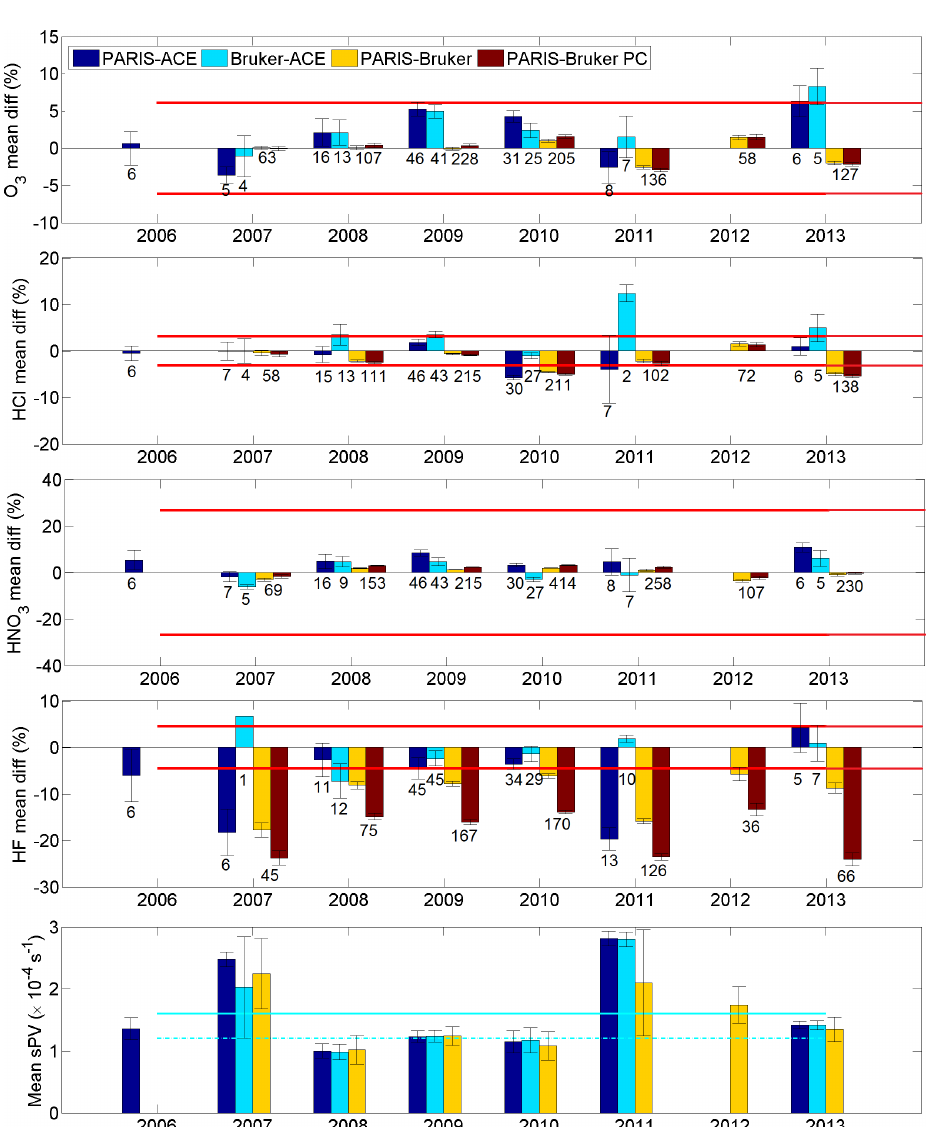
Figure 3. Mean differences for the stratospheric species estimated for each year (late February to early April) between PARIS-IR and ACE- FTS (blue), the Bruker 125HR and ACE-FTS (cyan), and PARIS-IR and the Bruker 125HR using total columns (yellow) and partial columns (red) for the comparison. The error bars display the standard error of the mean differences. The number displayed below each bar represents the number of pairs. The combined retrieval uncertainty from PARIS-IR and the Bruker 125HR is shown as a red line. The lower panel illustrates the average sPV along the line of sight at 20km of the pairs that are compared. The cyan solid and dashed lines represent the inner and outer polar vortex edge,